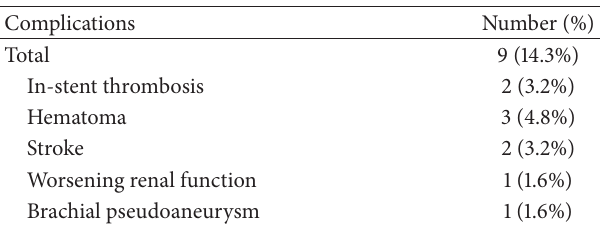
Table 4: Frequency of